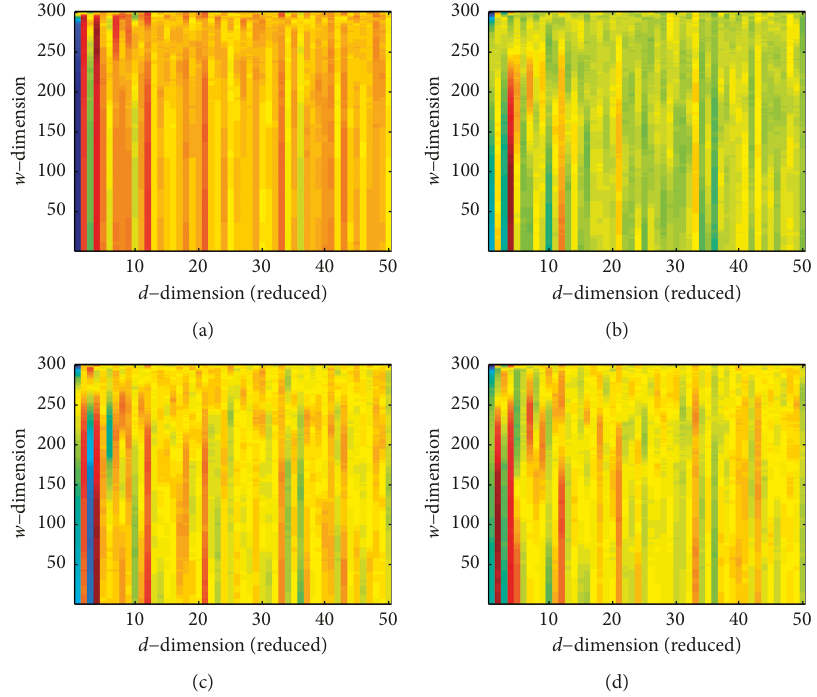
Figure 14: An example of the eigenimages of dataset D1: (a) normal; (b) 0.007 in; (c) 0.014 in; (d) 0.021 in. Table 5: The classification accuracy for inner-race fault severity detection. Dataset